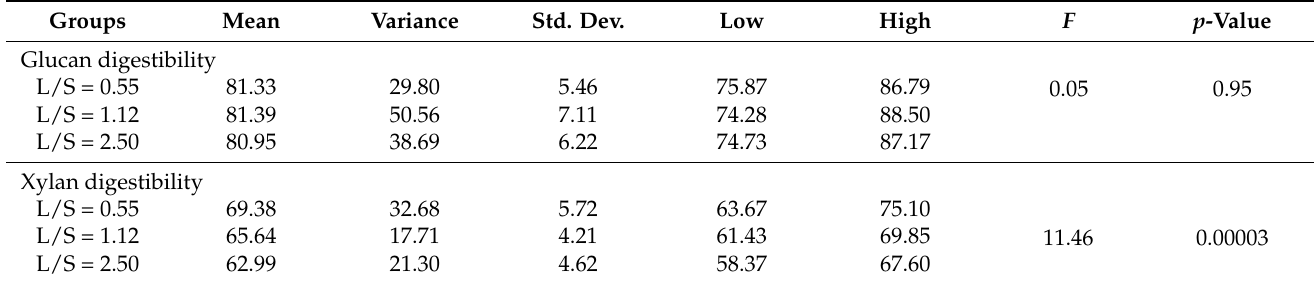
Figure 4. Effect of L/S ratio on ( a ) arabinan content, ( b ) xylan content, ( c ) glucan content, and ( d ) lignin content. Pretreatment conditions: L/S = 0.55, 1.12, and 2.5; 0.1 g-NH 3 /g-biomass, 150 ◦ C, 24–120 h. Table 4. ANOVA results of glucan and xylan digestibility tests at different L/S